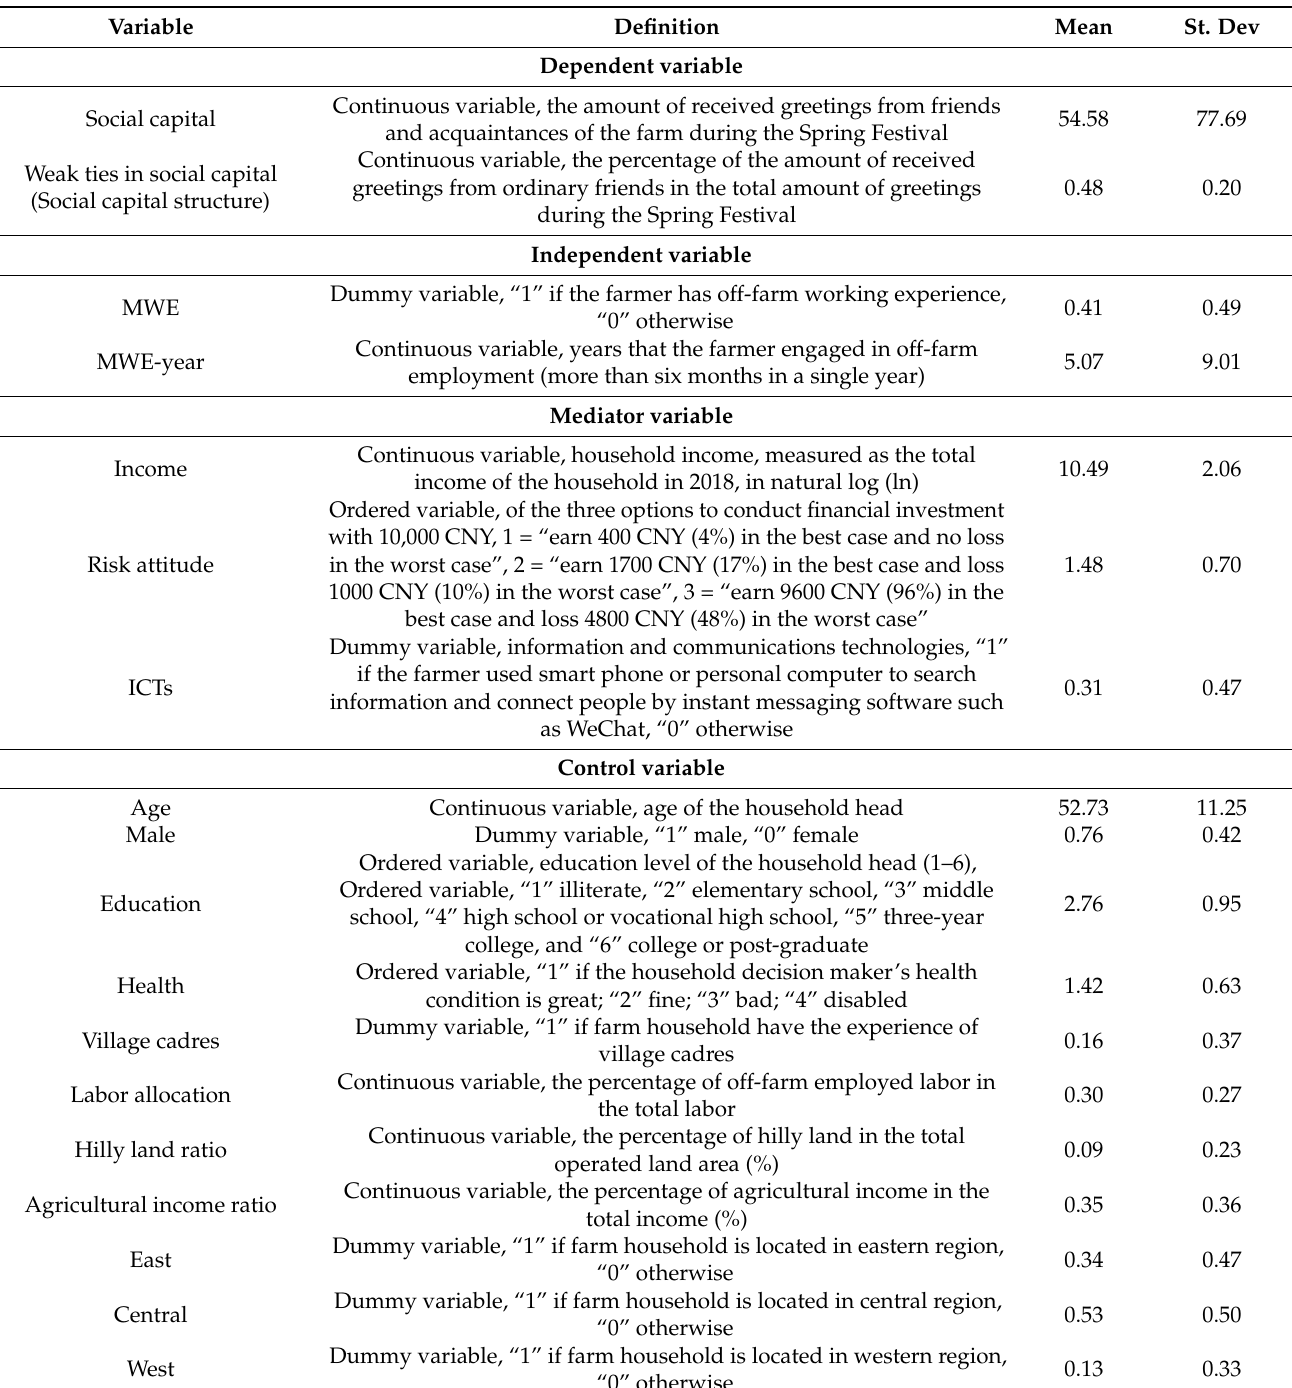
Table 2. Definition of variable and sample summary